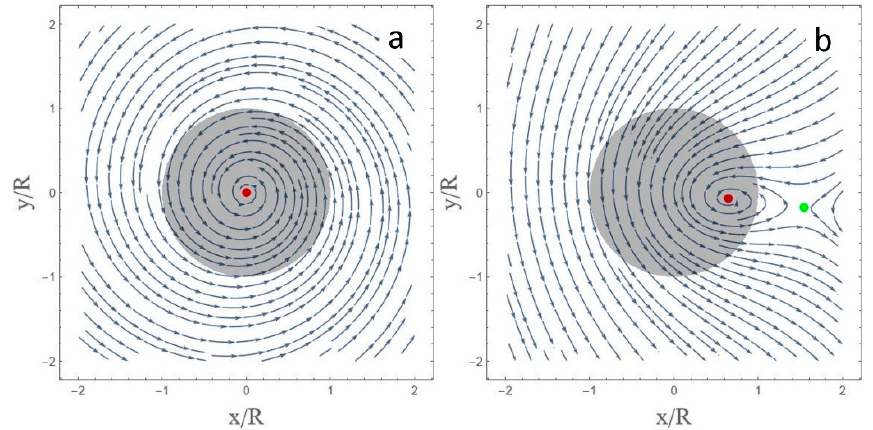
Figure 6. Horizontal streamlines scheme of the velocity field of a convergent eddy ( a ) and of the velocity field consisting of an eddy and a homogeneous drift current directed opposite to the y- direction ( b ). Grey area, the eddy core; the red and greed dots depict the positions of a focus and a saddle.